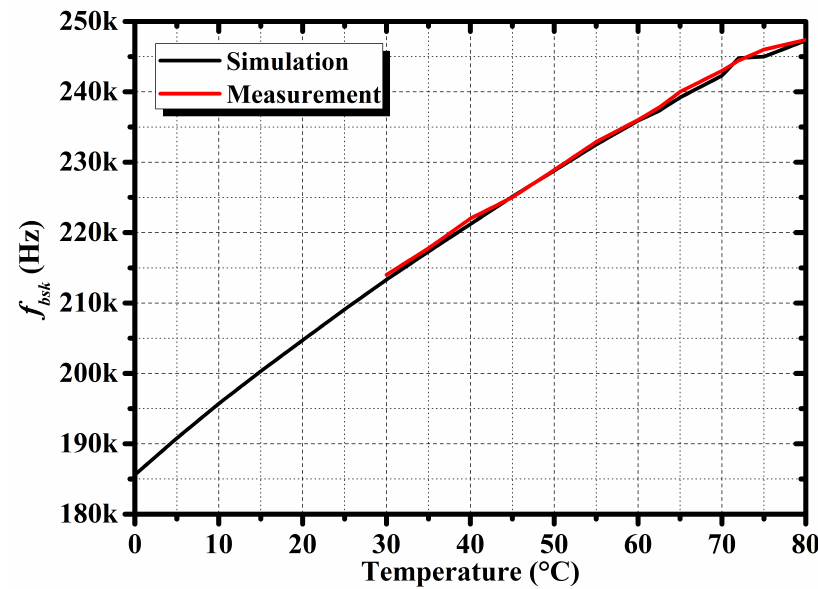
Figure 34. Temperature measurements of the fully assembled self-powered temperature